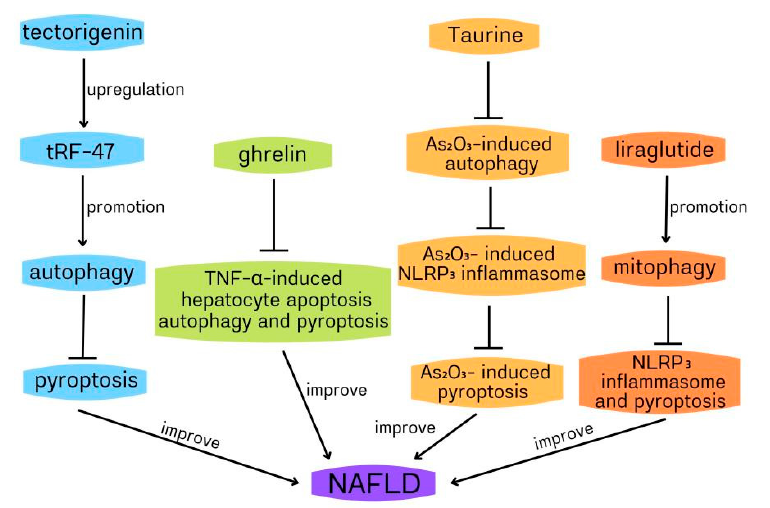
Figure 3. The protective role of autophagy and pyroptosis against non-alcoholic fatty liver disease (NAFLD) .